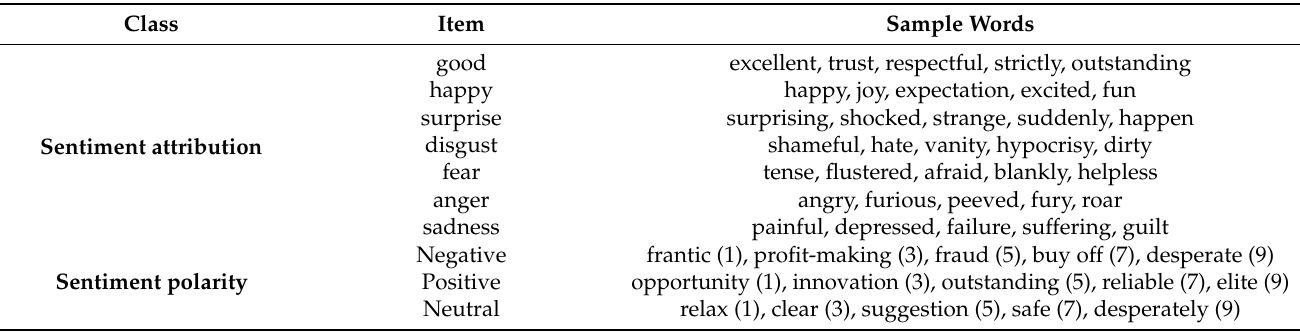
Table 1. DLUT Sentiment Polarity and Attribute Word